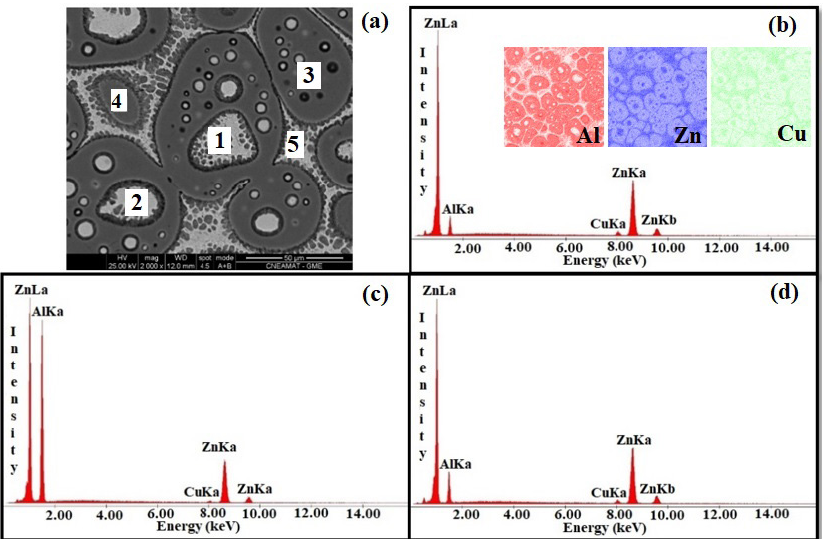
Figure 8. SEM images of ZA27 alloys during 20 min at 460 °C: (a) the ZA27 alloy contained Cu and Mg with the measuring points by EDAX: (1-2) Intraglobular, (3-4) Globular and (5) Interglobular. (b) EDS spectra of interglobular zone with micrograph of mapping of elements, (c) EDS spectra of globular zone and (d) EDS spectra of intraglobular zone.